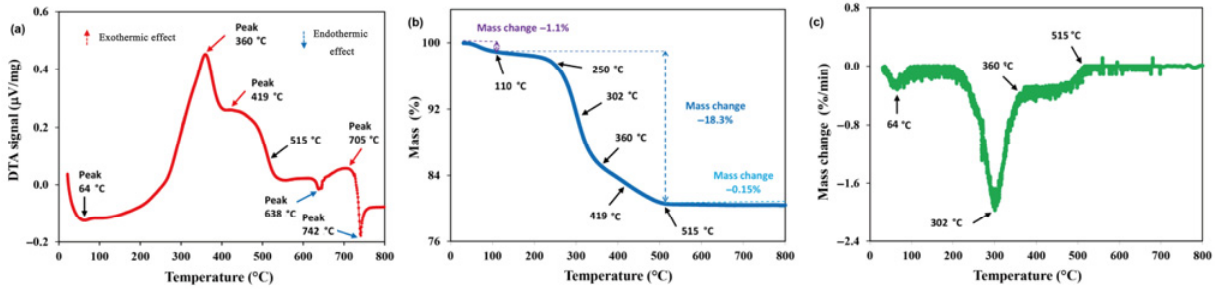
Fig. 3 Thermal analysis of Li 2 WO 4 green tapes in the temperature range of 20–800 ℃ : (a) DTA curve, (b) TG curve, and (c) DTG